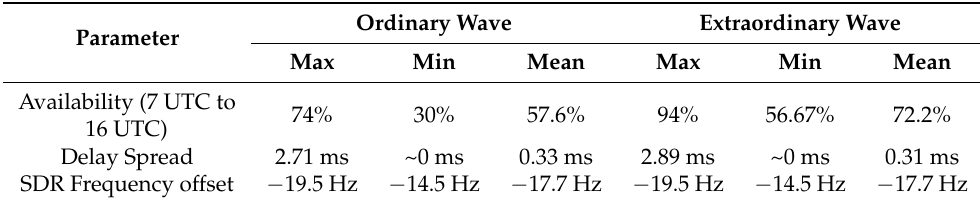
Table 3. Channel study summary.